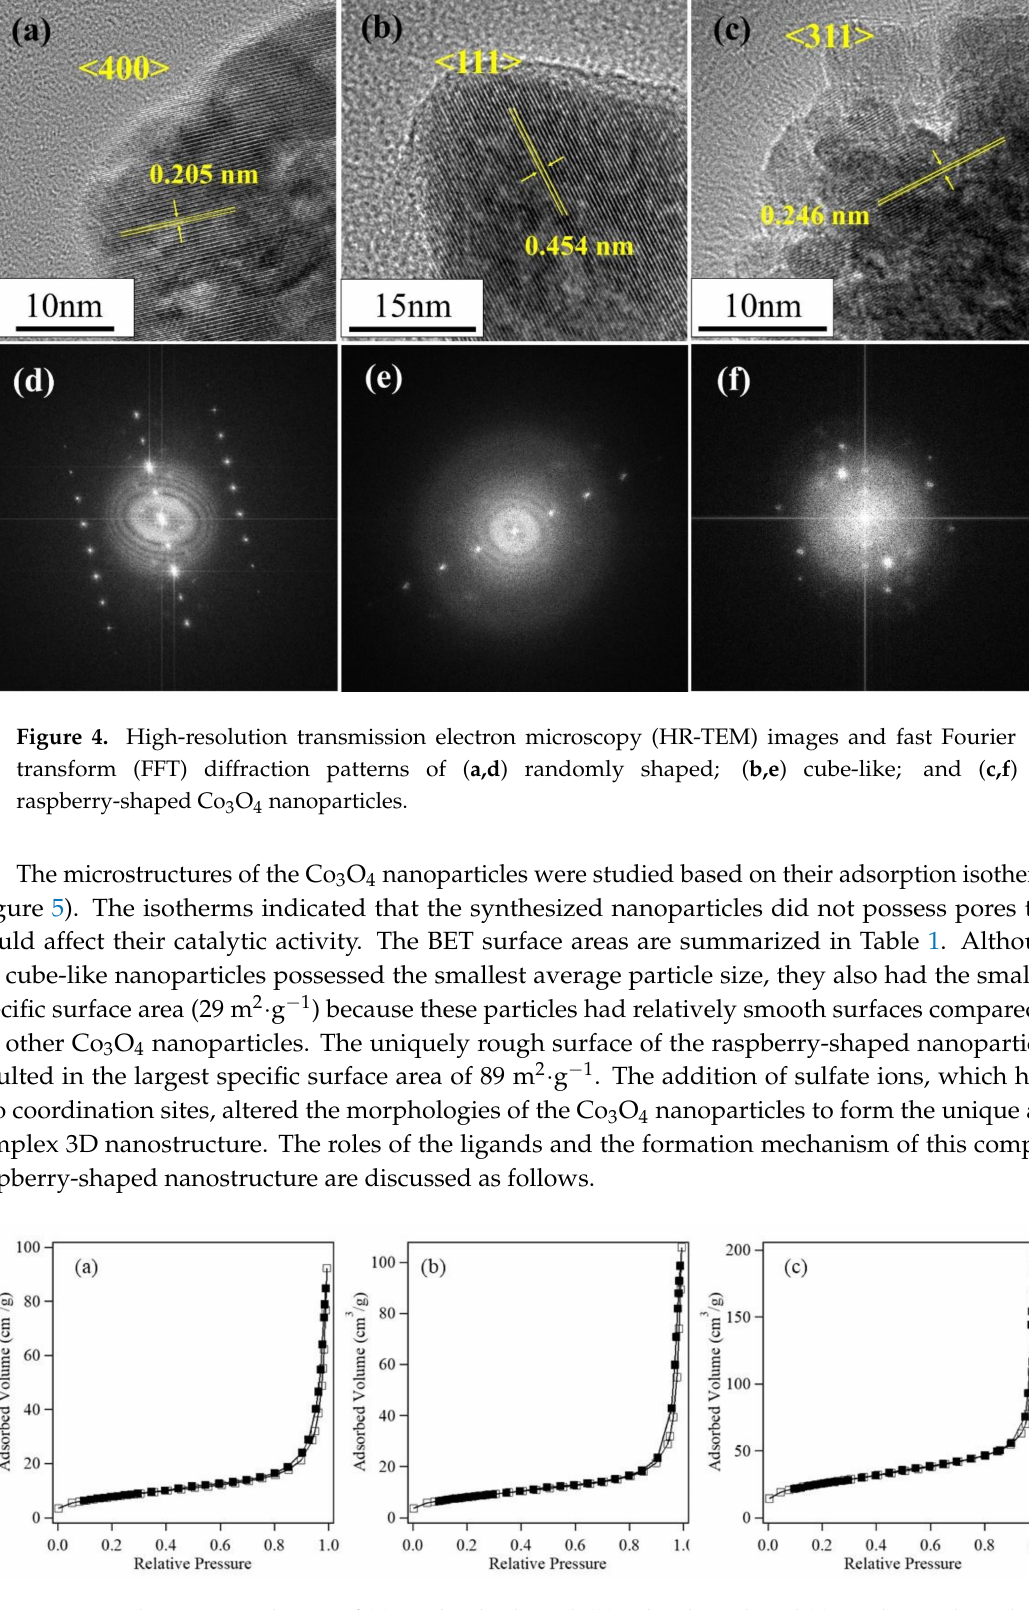
Figure 5. Adsorption isotherms of ( a ) randomly shaped; ( b ) cube-shaped; and ( c ) raspberry-shaped Co 3 O 4